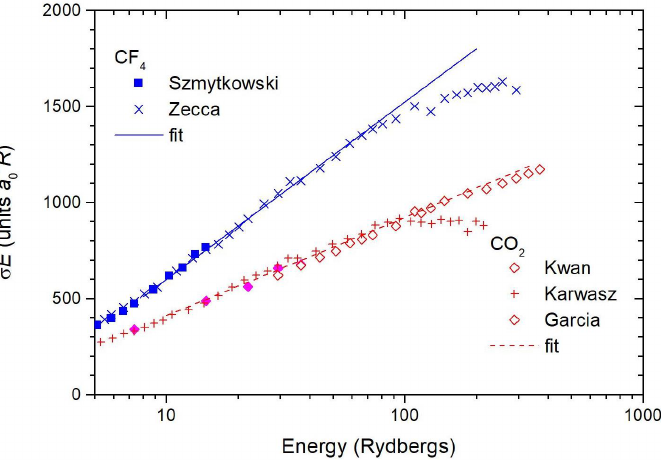
Figure 7. High-energy total cross sections for electron—CO 2 and CF 4 scattering. The line is the Bethe-Born fit, Equation (4). Experimental data are from Madrid laboratory [76], Trento [77,78], Detroit [79] and Gda´nsk